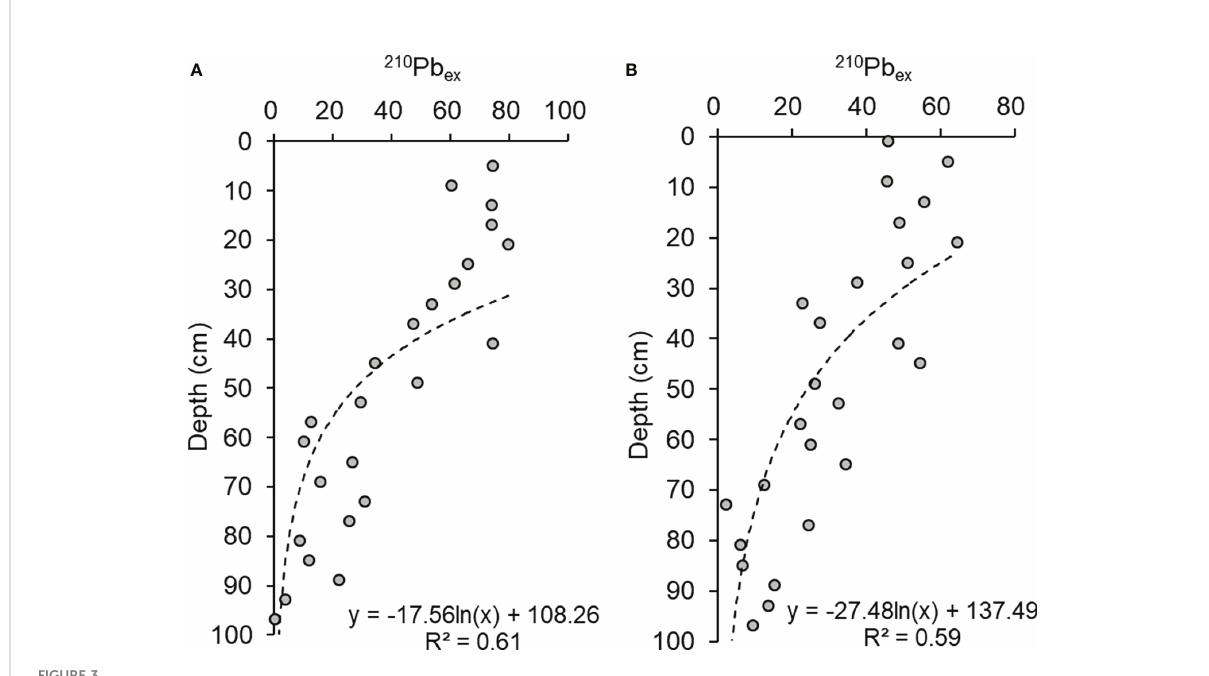
FIGURE 3 Relationship between 210 Pb ex and depth in C1 (A) and C2 (B)